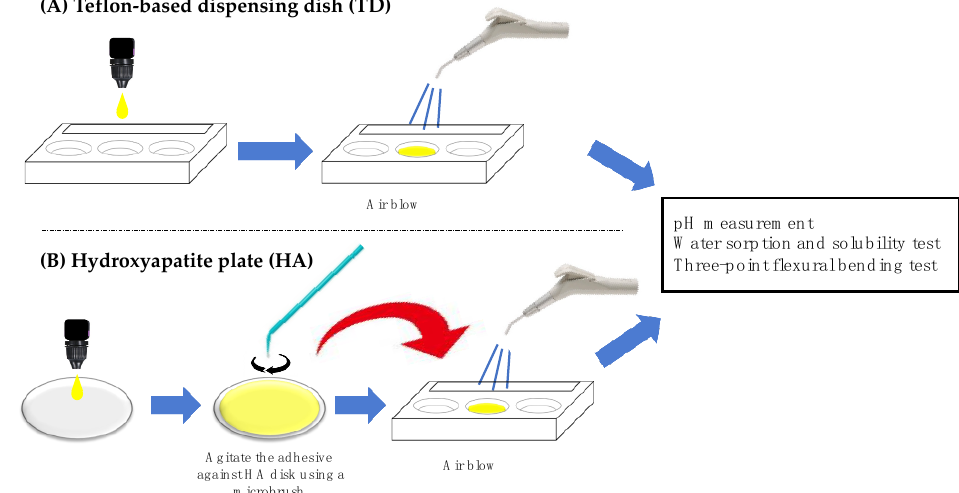
Figure 1. Schematic illustration of the manipulation and preparation of the 1-SEAs.